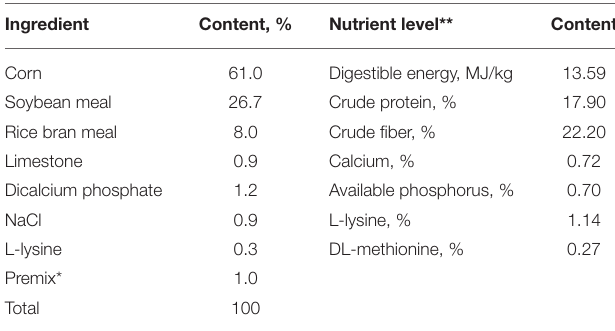
TABLE 1 | Composition and nutrient levels of the basal diet [dry matter (DM)